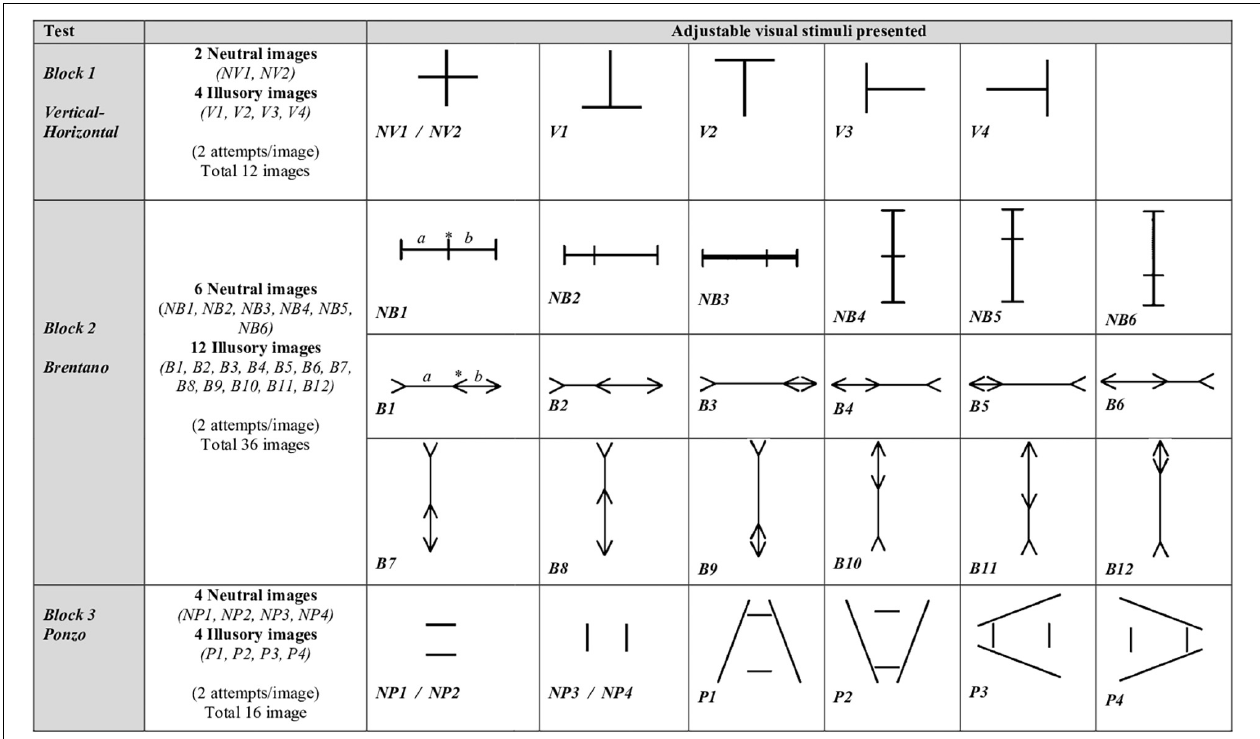
FIGURE 1 | Adjustable visual stimuli presented. Number, type of image (illusory and neutral) and name of the figures shown in each block. Three blocks of images were presented (the Vertical-Horizontal test, the Brentano version of the Müller Lyer test and the Ponzo test). Illusory and neutral images were presented randomly within the three test blocks with an interval of 1 min between the blocks and two repetitions per image, totaling 64 figures per experimental session. To perform the Method of Adjustment, the individual would have to compare the length of the straight segments. If deemed necessary, the individual could adjust one of the straight segments so that they have the same subjective length. For the Vertical-Horizontal Test the vertical straight line should be compared to the horizontal one. The individual could increase or decrease the length of the horizontal ( NV1, V3, and V4 ) or vertical ( NV2, V1, and V2 ) straight line of the image. For the Brentano test, the individual could modify the position of the central arrow (in illusory images) or the central straight line (in neutral images), in order to make both line segments (straight segments “a” and “b”) subjectively equal on the main axis of the figure. The central element ( ∗ ) could be moved freely in the direction of the horizontal axis (to the right or left of the image, in the figures : NB1, NB2, NB3, B1, B2, B3, B4, B5, and B6 ) or in the direction of the axis vertical (up or down in figures: NB4, NB5, NB6, B7, B8, B9, B10, B11, and B12 ). NB1 , lines at 90 ◦ . Central line on the point of objective equality. NB2 , lines at 90 ◦ . Central line displaced to the left by 18.66 mm. NB3 , lines at 90 ◦ . Central line displaced to the right by 18.66 mm. NB4 , lines at 180 ◦ . Central line on the point of objective equality. NB5 , lines at 180 ◦ . Central line displaced up by 18.66 mm. NB6 , lines at 180 ◦ . Central line displaced down by 18.66 mm. B1 , arrow pointing right. Central arrow on the point of objective equality. B2 , arrow pointing right. Central arrow displaced to the left by 18.66 mm. B3 , arrow pointing right. Central arrow displaced to the right by 18.66 mm. B4 , arrow pointing left. Central arrow on the point of objective equality. B5 , arrow pointing left. Central arrow displaced to the left by 18.66 mm. B6 , arrow pointing left. Central arrow displaced to the right by 18.66 mm. B7 , arrow pointing down. Central arrow on the point of objective equality. B8 , arrow pointing down. Central arrow displaced up by 18.66 mm. B9 , arrow pointing down. Central arrow displaced down by 18.66 mm. B10 , arrow pointing up. Central arrow on the point of objective equality. B11 , arrow pointing up. Central arrow displaced down by 18.66 mm. B12 , arrow pointing up. Central arrow displaced up by 18.66 mm. For the Ponzo test, the individual can modify the length of one of the straight segments in the direction of the horizontal ( NP1, NP2, P1, and P2 ) or vertical ( NP3, NP4, P3, and P4 ) axis of the image. NP1 , top horizontal line adjustable. The individual should compare the length of the top horizontal line with the bottom one and adjust the top horizontal line (increasing or decreasing) so that both horizontal lines have the same subjective length. NP2 , bottom horizontal line adjustable. NP3 , right vertical line adjustable. NP4 , left vertical line adjustable. P1 , top horizontal line adjustable. P2 , bottom horizontal line adjustable. P3 , left vertical line adjustable. P4 , right vertical line